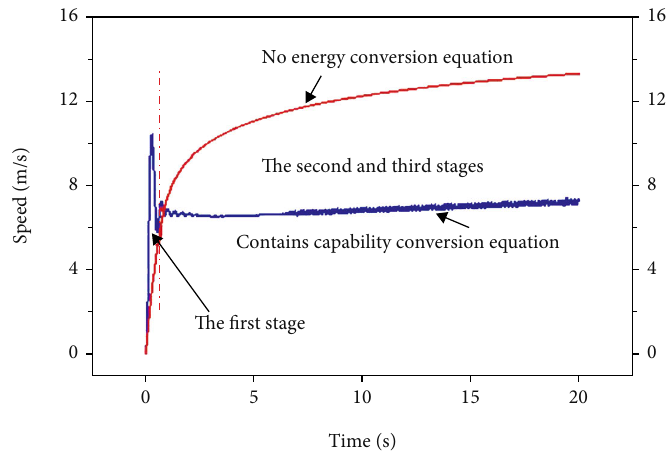
Figure 5: In fl uence of energy conversion